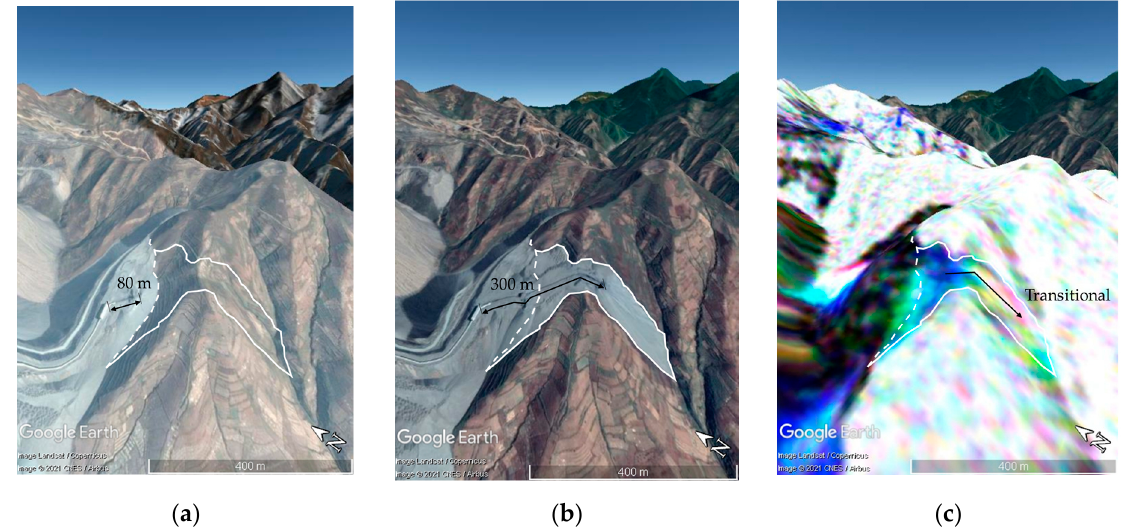
Figure 22. East Dumping Site 3 (ED3). ( a , b ) are Google Earth images taken on 7 October 2015 and 26 September 2019,